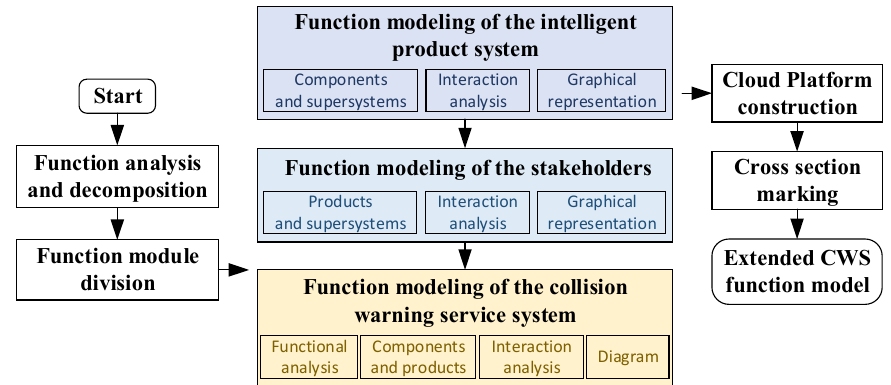
Figure 4. Proposed modeling process of the extended CWS.